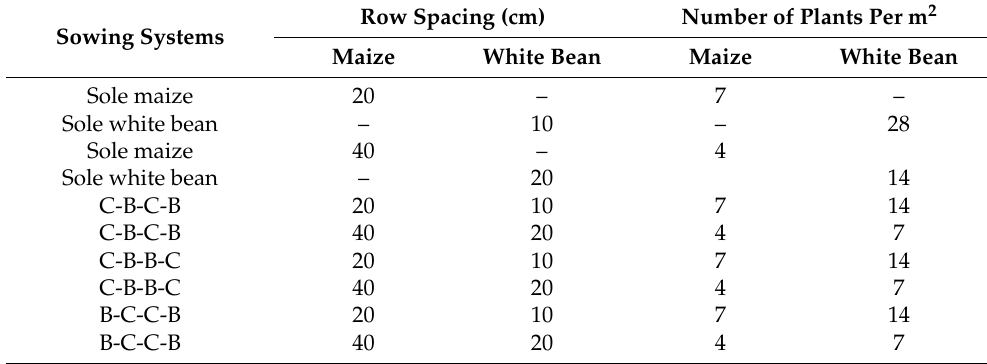
Table 4. Different sowing systems at the research station, Nur Sultan, Kazakhstan. Row Spacing (cm) Number of Plants Per m 2 Sowing Systems Maize White Bean Maize White Bean Sole maize Sole white